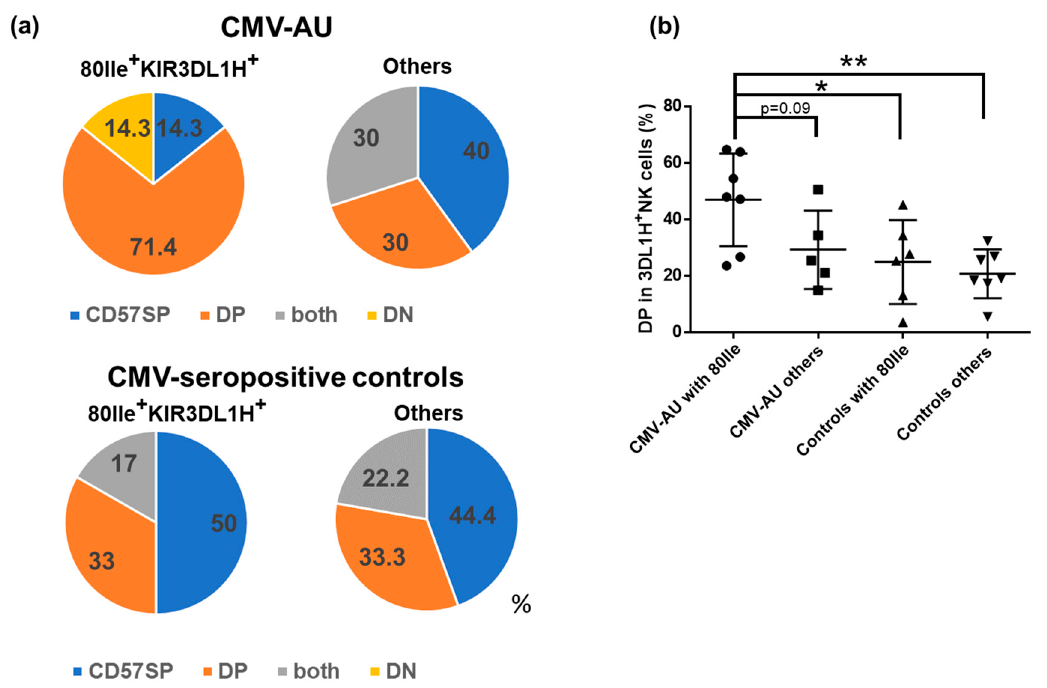
Figure 3. Expansion of CD57/KLRG1 DP NK cells in CMV-AU patients carrying HLA-B Bw4 80Ile and KIR3DL1H. ( a ) The proportion of expanded NK cell subsets among CMV-AU patients and CMV-seropositive healthy individuals in the presence or absence of HLA-B Bw4 80Ile and KIR3DL1H (CMV-AU, n = 17; CMV-seropositive controls, n = 15). ( b ) Distributions of KIR3DL1H + NK cells among the CD57/KLRG1 subsets. CD57/KLRG1 DP subset frequencies among KIR3DL1H + NK cells were significantly elevated in CMV-AU patients carrying HLA-B Bw4 80Ile as compared to CMV-seropositive controls (CMV-AU, n = 12; CMV-seropositive controls, n = 13; ANOVA p = 0.0097). Data represent the mean+ standard deviation. * p < 0.05, ** p < 0.01.